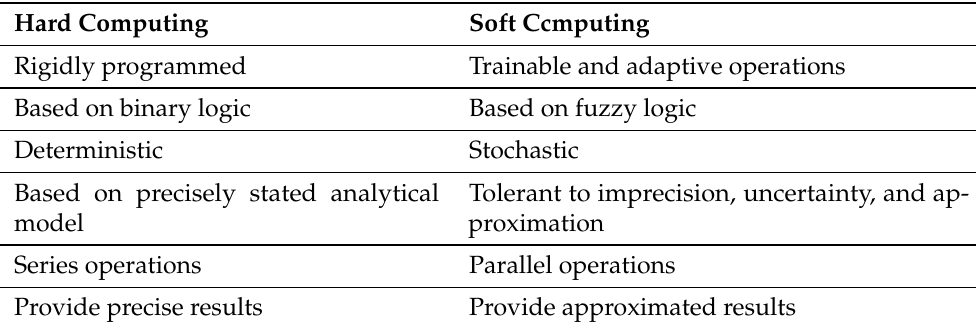
Table 1. Comparisons between hard and soft computing strategies. Hard